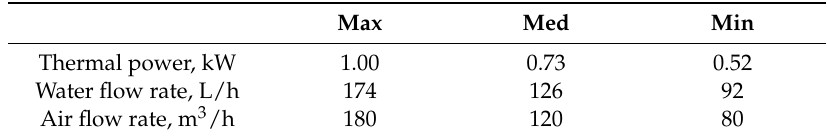
Figure 5. Daily profiles of internal heat gains for the apartment. Table 4. Fan coil unit (FCU) Manufacturer’s Datasheet 1